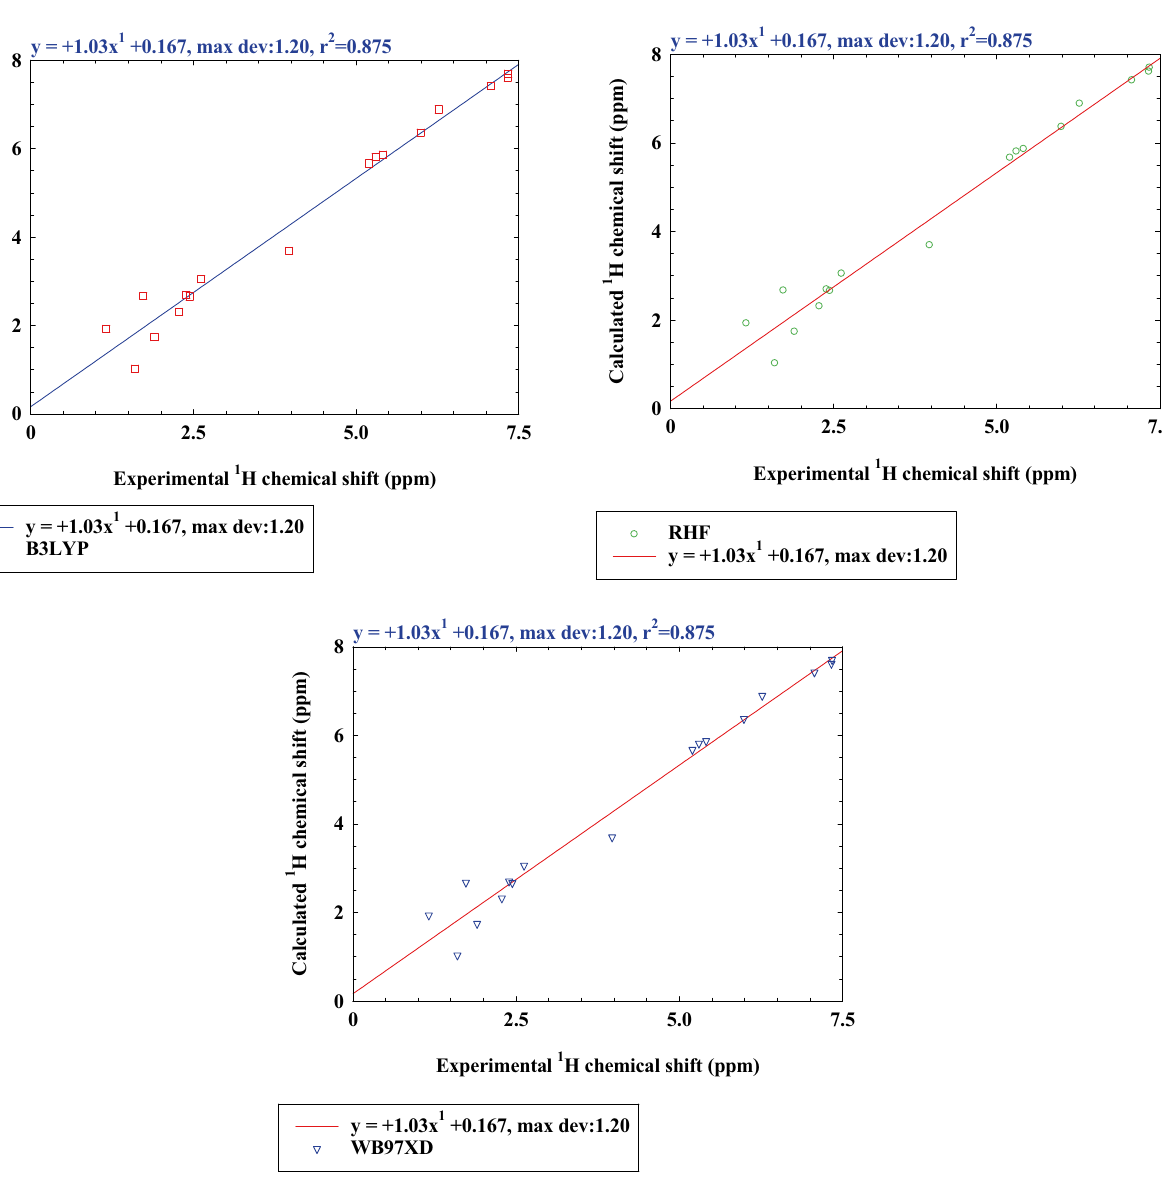
Fig. 9 Comparison of experimental [9] and theoretical 1 H chemical shifts of andirobin calculated at the RHF, B3LYP and wB97XD levels with 6–311 G(d,p) basis